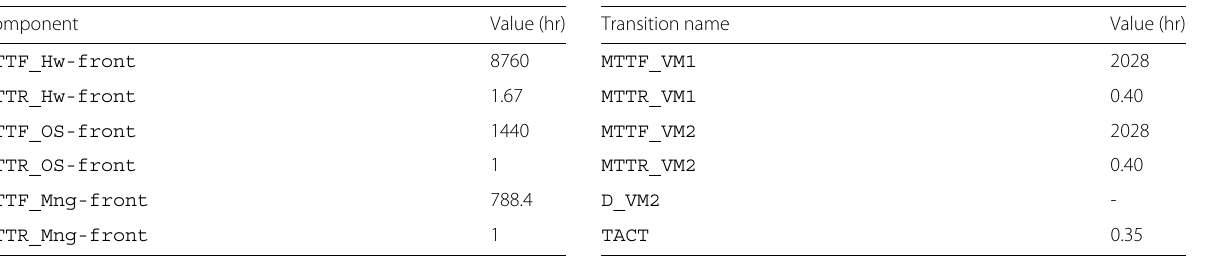
Table 2 Parameters for the front-end submodel